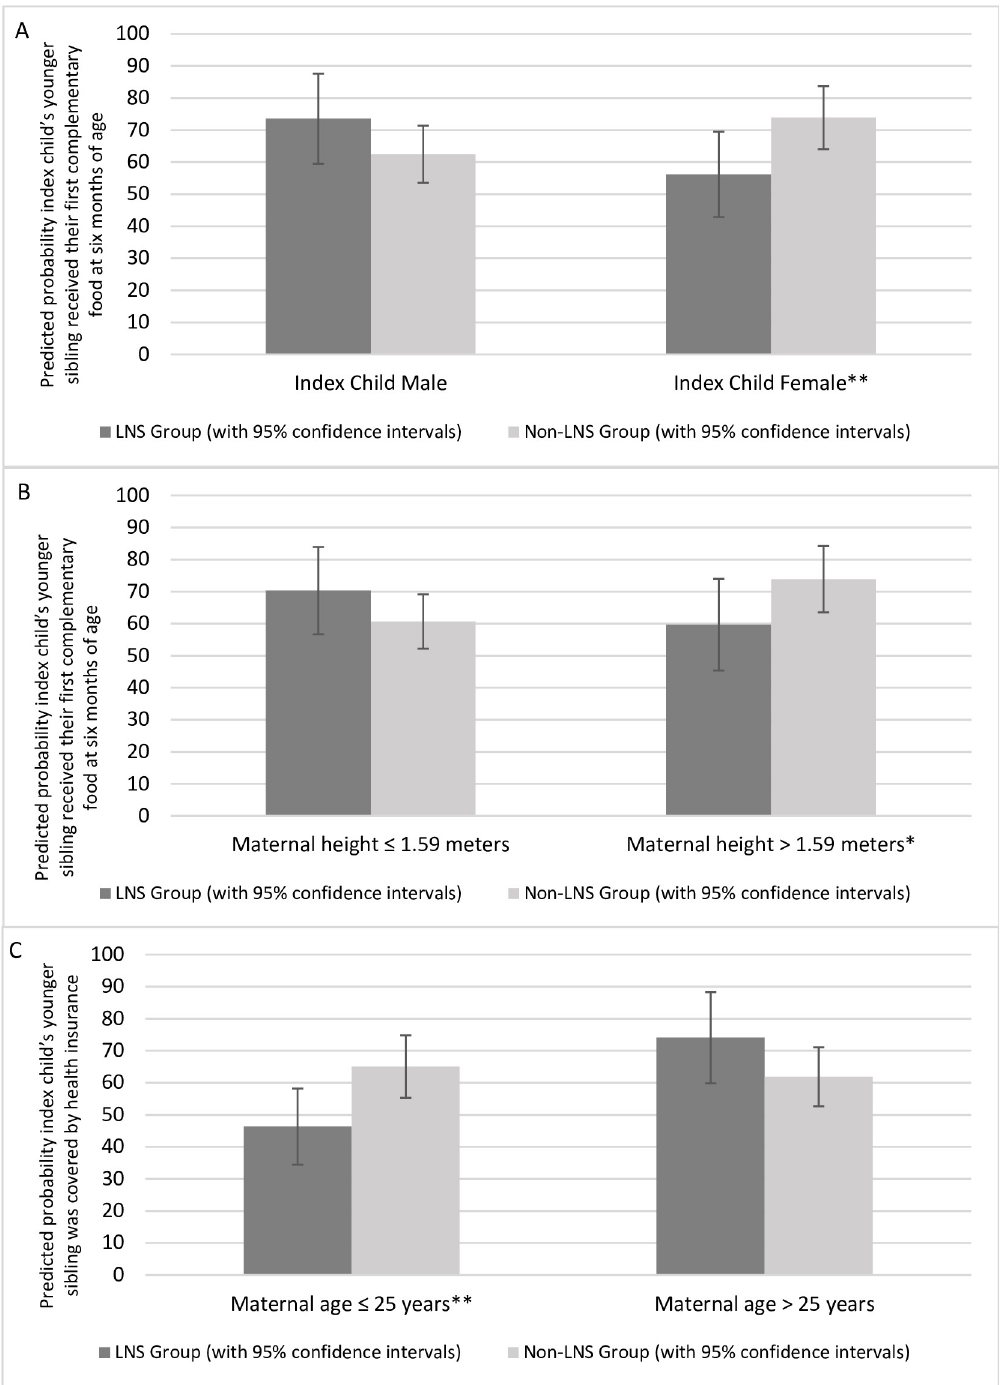
Fig 4. Heterogeneity in the effect of the intervention on investments in the index child’s younger sibling. (A) Heterogeneity, by index child gender, in the effect of the intervention on the probability the index child’s younger sibling received their first complementary food at six months of age. (B) Heterogeneity, by maternal height, in the effect of the intervention on the probability the index child’s younger sibling received their first complementary food at six months of age. (C) Heterogeneity, by maternal age, in the effect of the intervention on the probability the index child’s younger sibling was covered by health insurance. ��� (p < .01), �� (p < .05), � (p < .1).